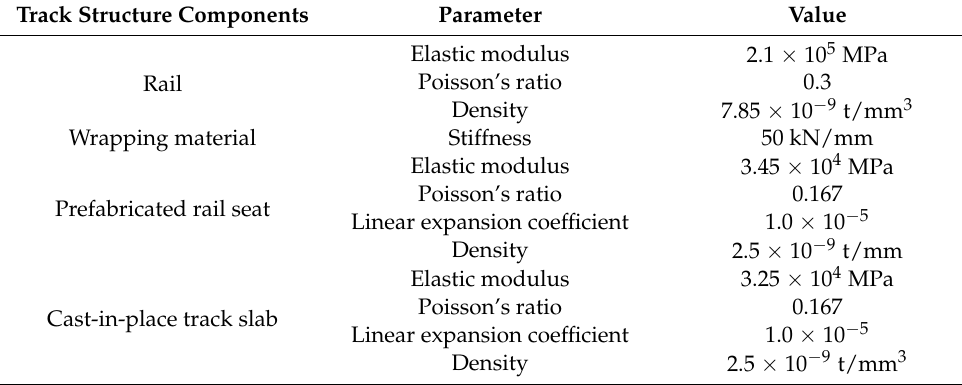
Table 2. Track structure